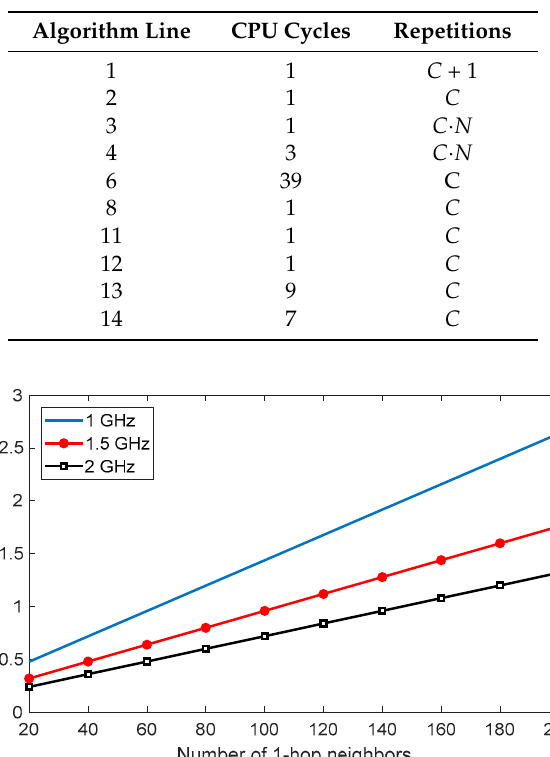
Table 3. Computational cost of Algorithm 2.